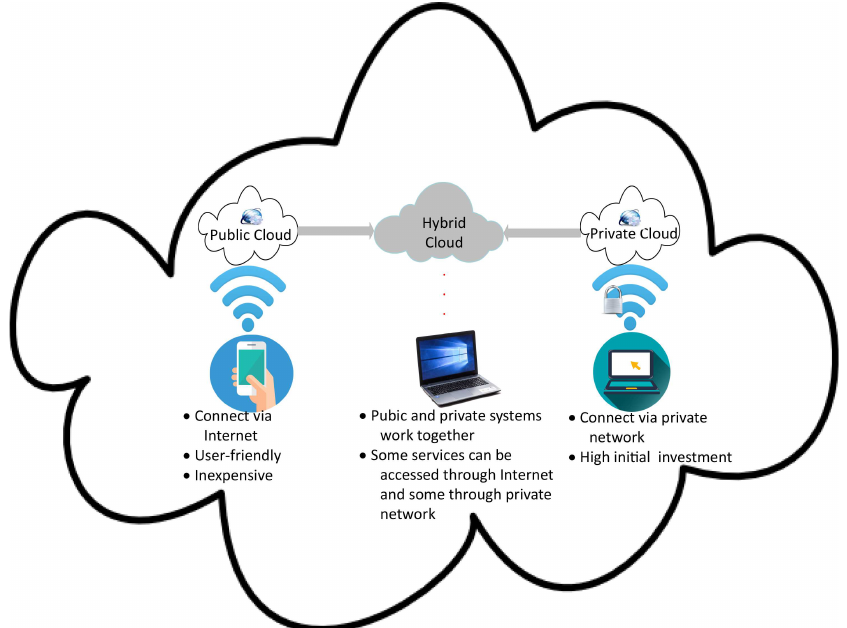
Figure 2. Types of